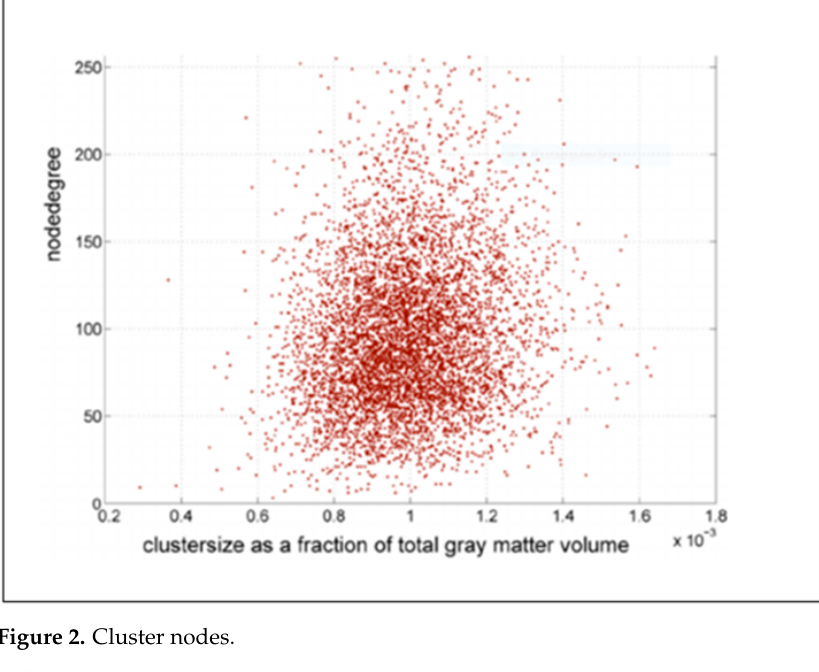
Figure 2. Cluster nodes.